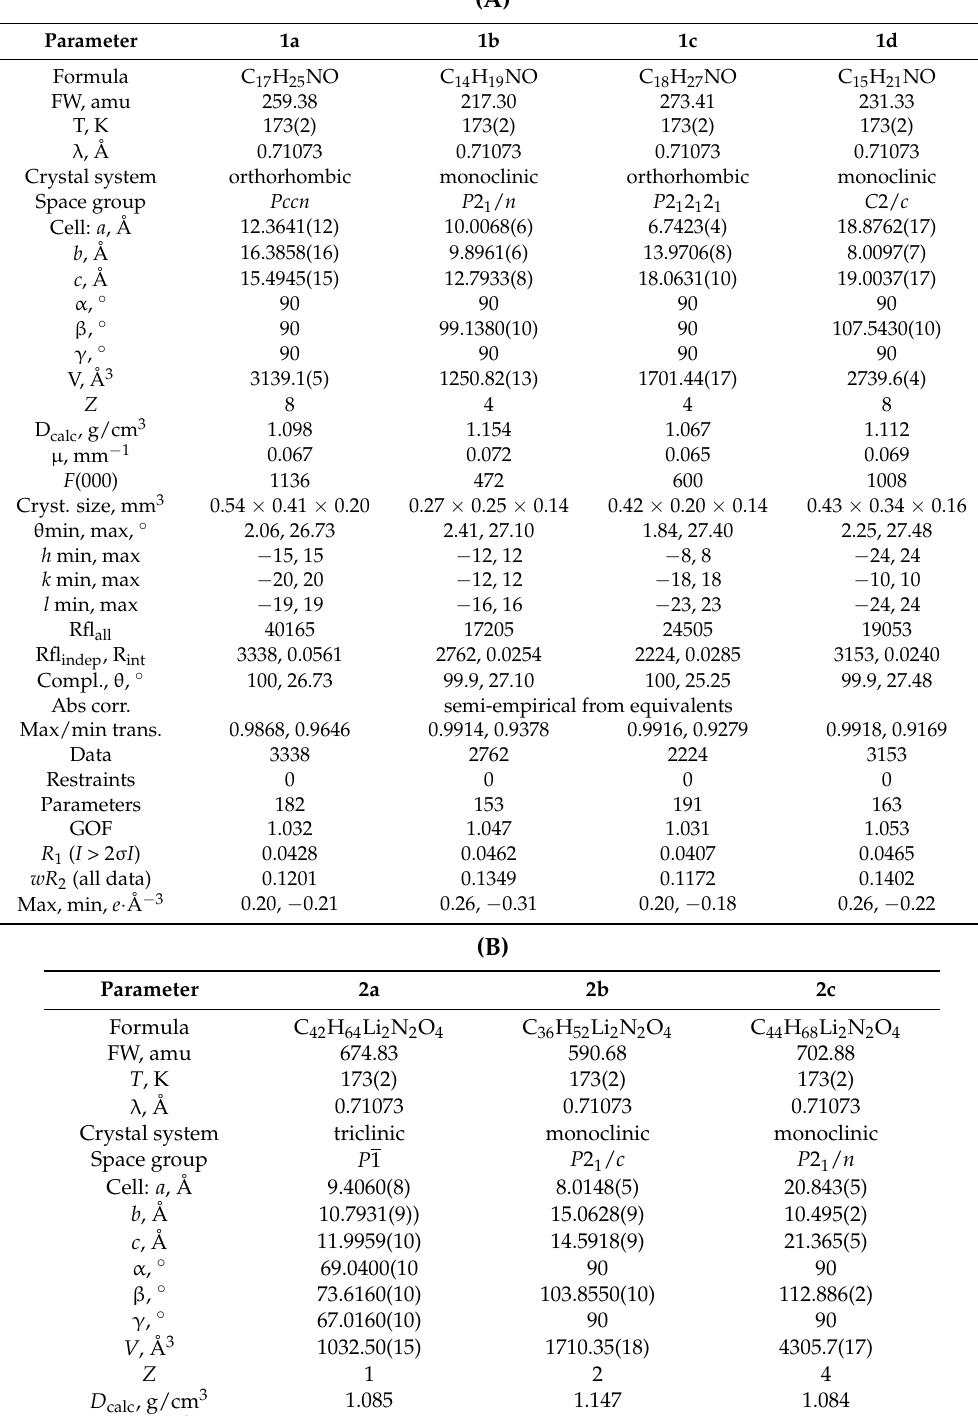
Table A1. Crystal data, structure collection and refinement data for X-ray crystallography 1